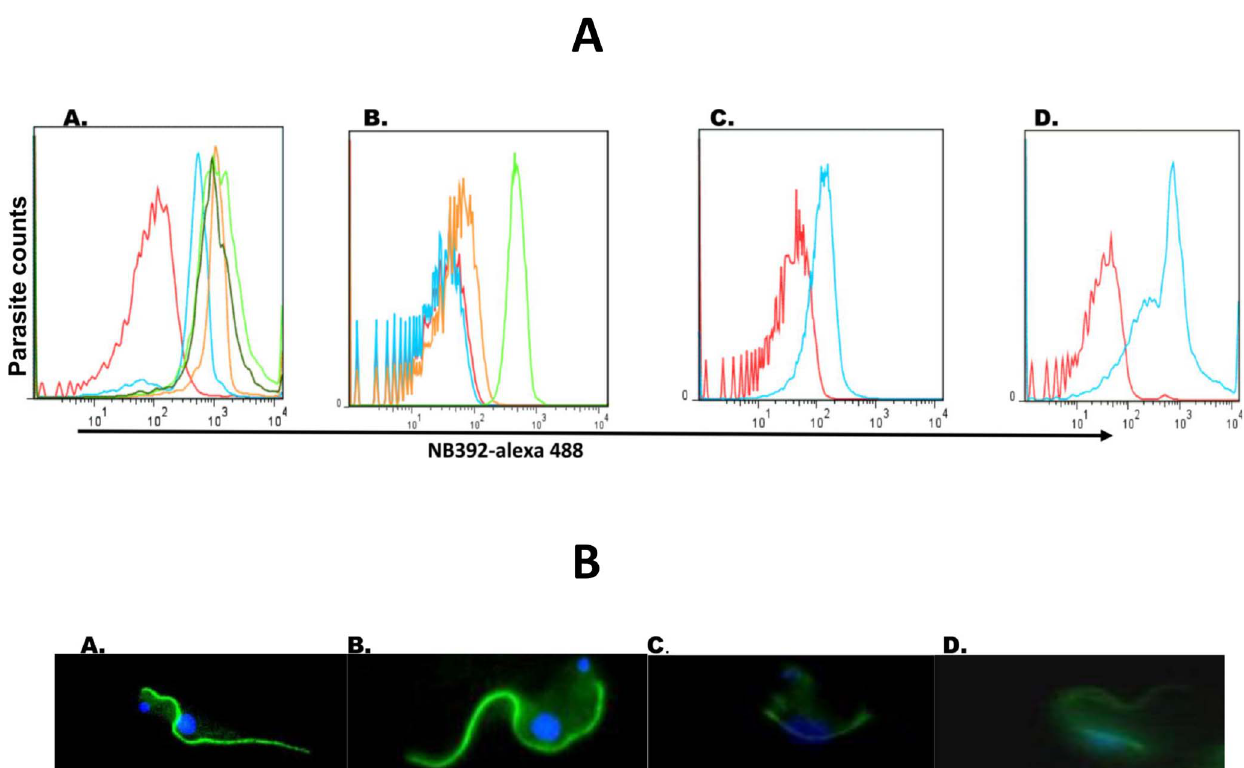
Fig. 3. A. Flowcytometric profiles showing binding of ALEXA-labeled Nb392 to fixed and permeabilised trypanosomes. Fixed and permeabilised cells: unstained (red) and stained (blue) T. evansi STIB 816, stained T. evansi Itmas 010399b (light green), stained T. evansi Itmas 120399b (dark green), stained T. evansi Itmas 150399b (orange); B) Unstained live T. brucei AnTat1.1 (red), fixed and permeabilised T. brucei AnTat1.1 unstained (blue), stained (green), stained with control NbBCII 10 (orange); C) Fixed and permeabilised T. vivax IL700 unstained (red) or stained (blue); D) Fixed and permeabilised T. congolense Tc13 unstained (red) or stained (blue). B. Direct Immunofluorescense assay of fixed and permeabilised trypanosomes. Fixed and permeabilised trypanosomes incubated with Alexa 488- labeled Nb392 (green) and with DAPI (blue) staining nuclear and mitochondrial DNA. A) T. evansi STIB 816; B) T. brucei; C) T. congolense Tc13; D) T. vivax IL700. Magnification; X1000.